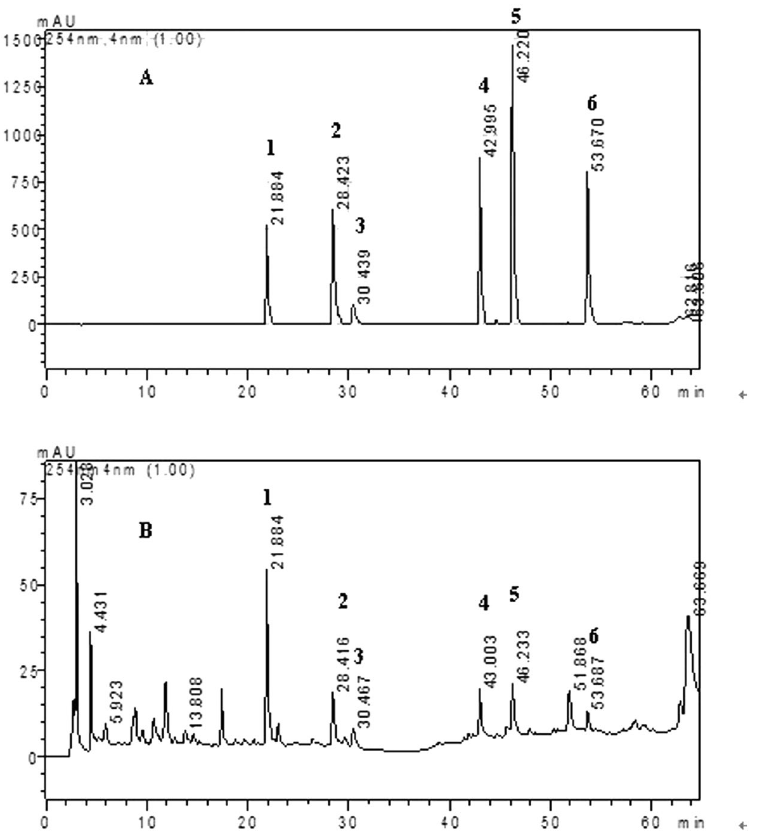
Figure 1. HPLC fingerprint of mix standards ( A ) and PRM ( B ). 1: mangiferin, 2: calycosin-7-O-glucoside, 3: liquiritin, 4: ononin, 5: calycosin, 6: